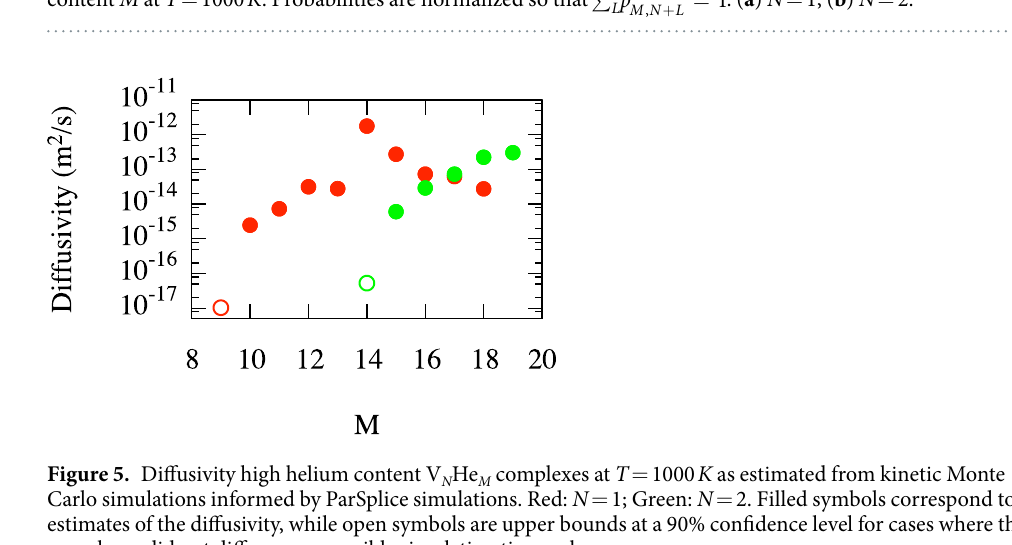
. The p 1 L M N L , +